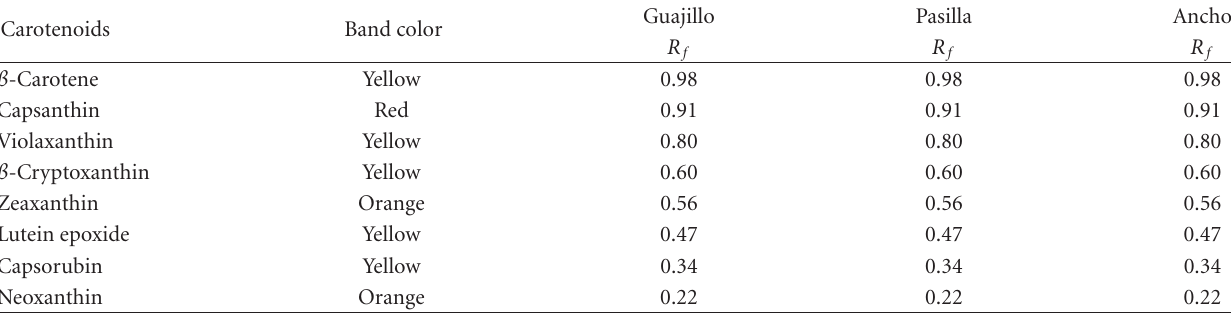
Table 2: R f of pigments from guajillo, pasilla, and ancho peppers separated by TLC. Carotenoids Band color